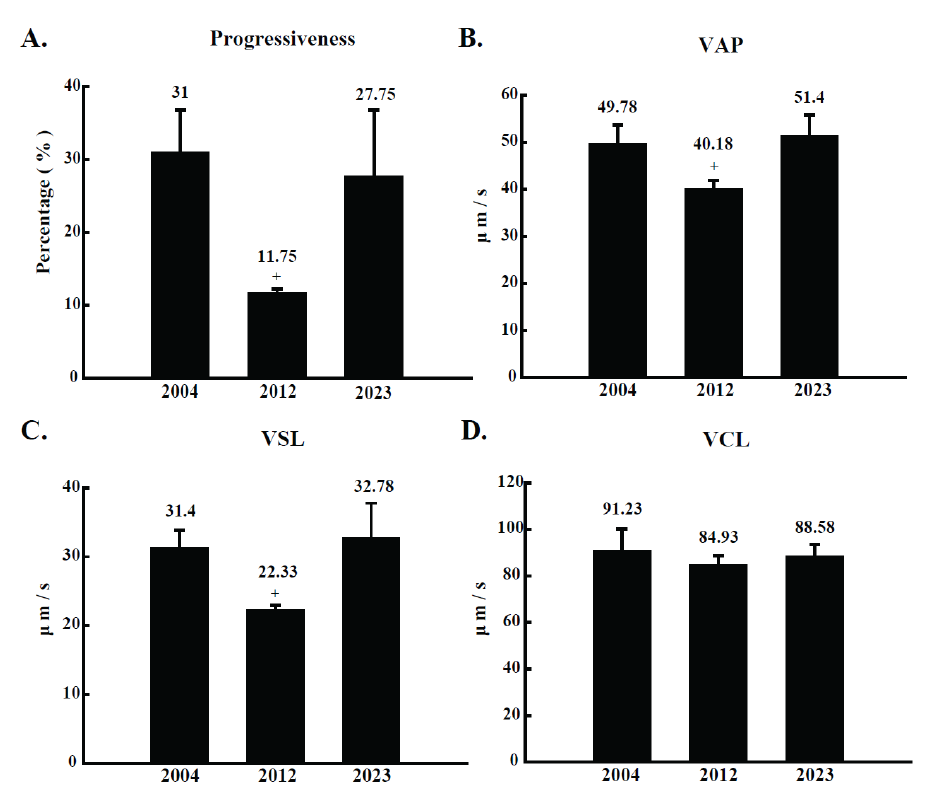
Figure 2. Comparison of detailed motion characteristics of semen from boar number 2004, 2012, and 2023. (A) progressiveness (%), (B) average path velocity (VAP, μm/s), (C) straightness linear velocity (VSL, μm/s) and (D) curve linear velocity (VCL, μm/s) were evaluated in CASA. Semen was collected at five different time from the boars (n = 5). The collected semen was divided in triplicates and applied to CASA analysis. The results are expressed as mean±SD. p<0.05. CASA, computer assisted semen analysis; SD, standard